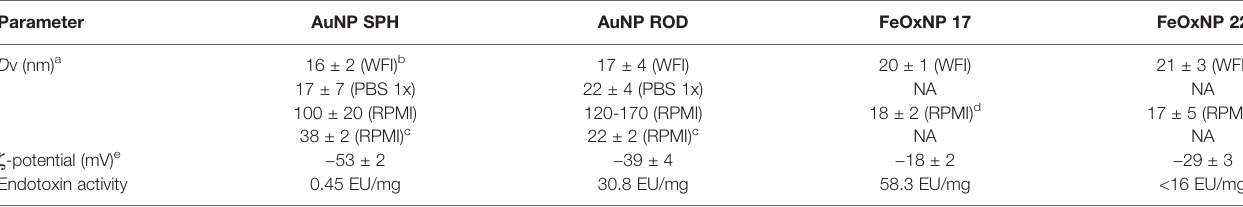
TABLE 2 | NP hydrodynamic